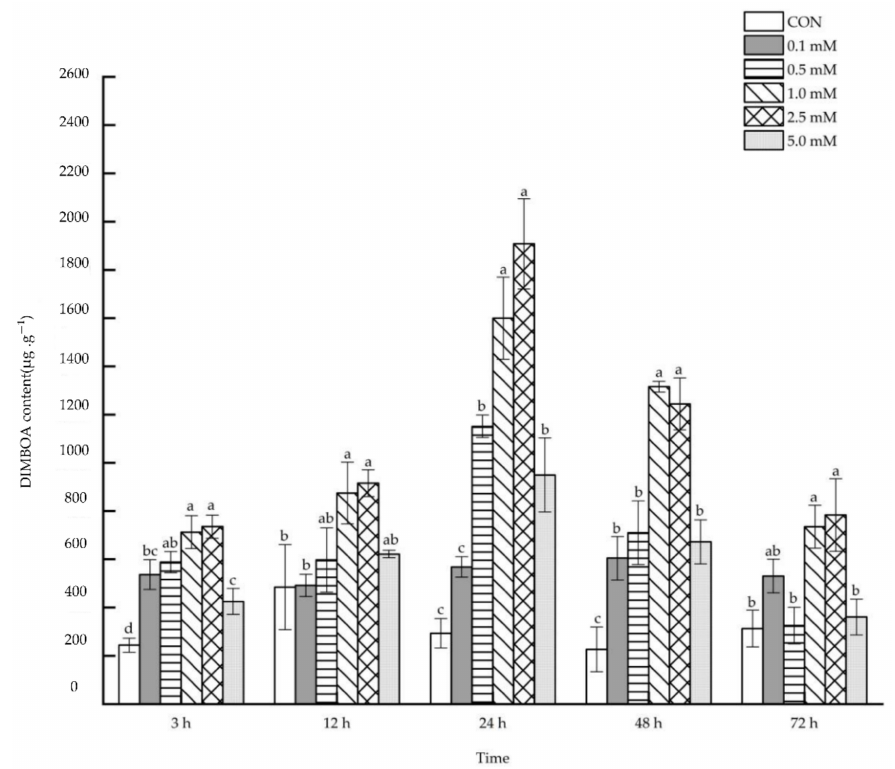
Figure 1. The direct effect of the SA concentration and post-treatment time on the DIMBOA content in leaves following exogenous foliar application. The data are presented as mean ± standard errors. The significance of data was determined by the Duncan method. The difference between different letters at the same time reached significant levels of